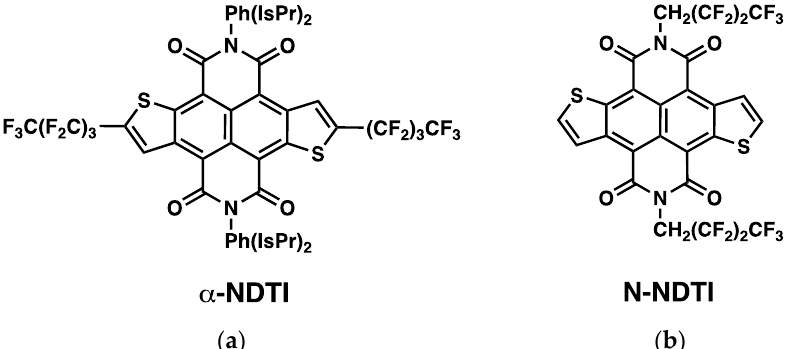
Figure 1. Structural formula of the two fluoroalkylated NDTI derivatives considered in this work. ( a ) α-NDTI . ( b ) N-NDTI . α -NDTI . ( b ) N-NDTI